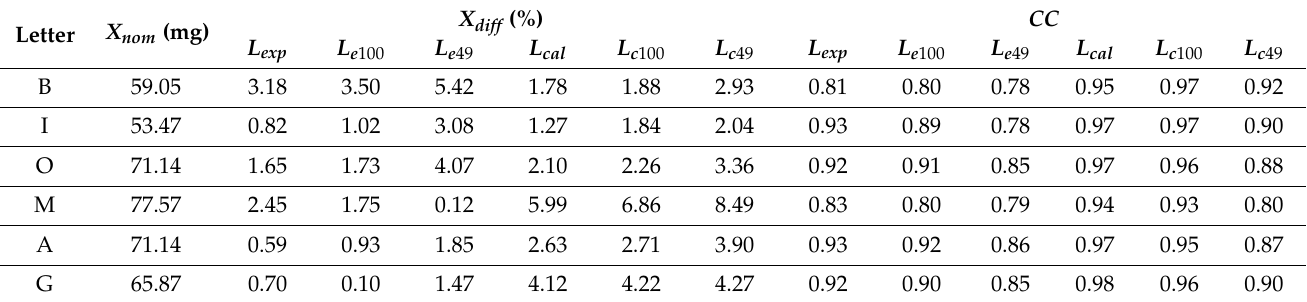
Figure 8. Reconstructed images and voltage maps of MNPs ’ distribution in the geometry of letters B , I , O , M , A , and G . The first row shows the nominal distributions; the second row shows the reconstructions using L exp ; the third row shows the reconstructions using L cal ; and the fourth row shows the voltage maps. Table 4. CC and X dif f values for the ACB reconstructions of calculated signals of bars’